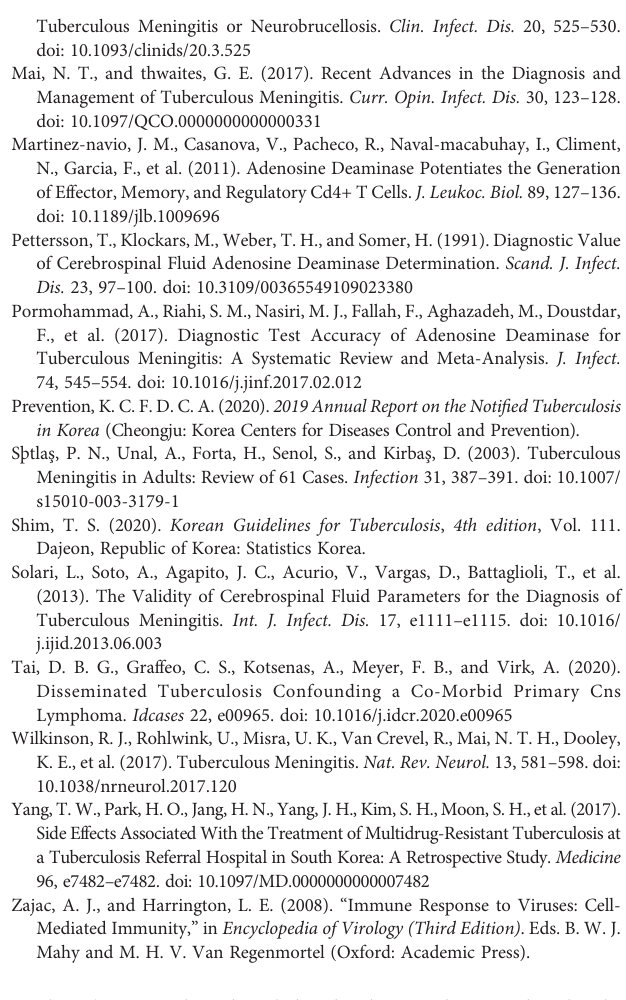
Supplementary Table 2 | Sensitivity, speci fi city, PPV and NPV of CSF-ADA for three most common diagnoses (i.e., TBM, HM, VM)TBM, tuberculous meningitis, HM, hematologic malignancy, VM, Viral